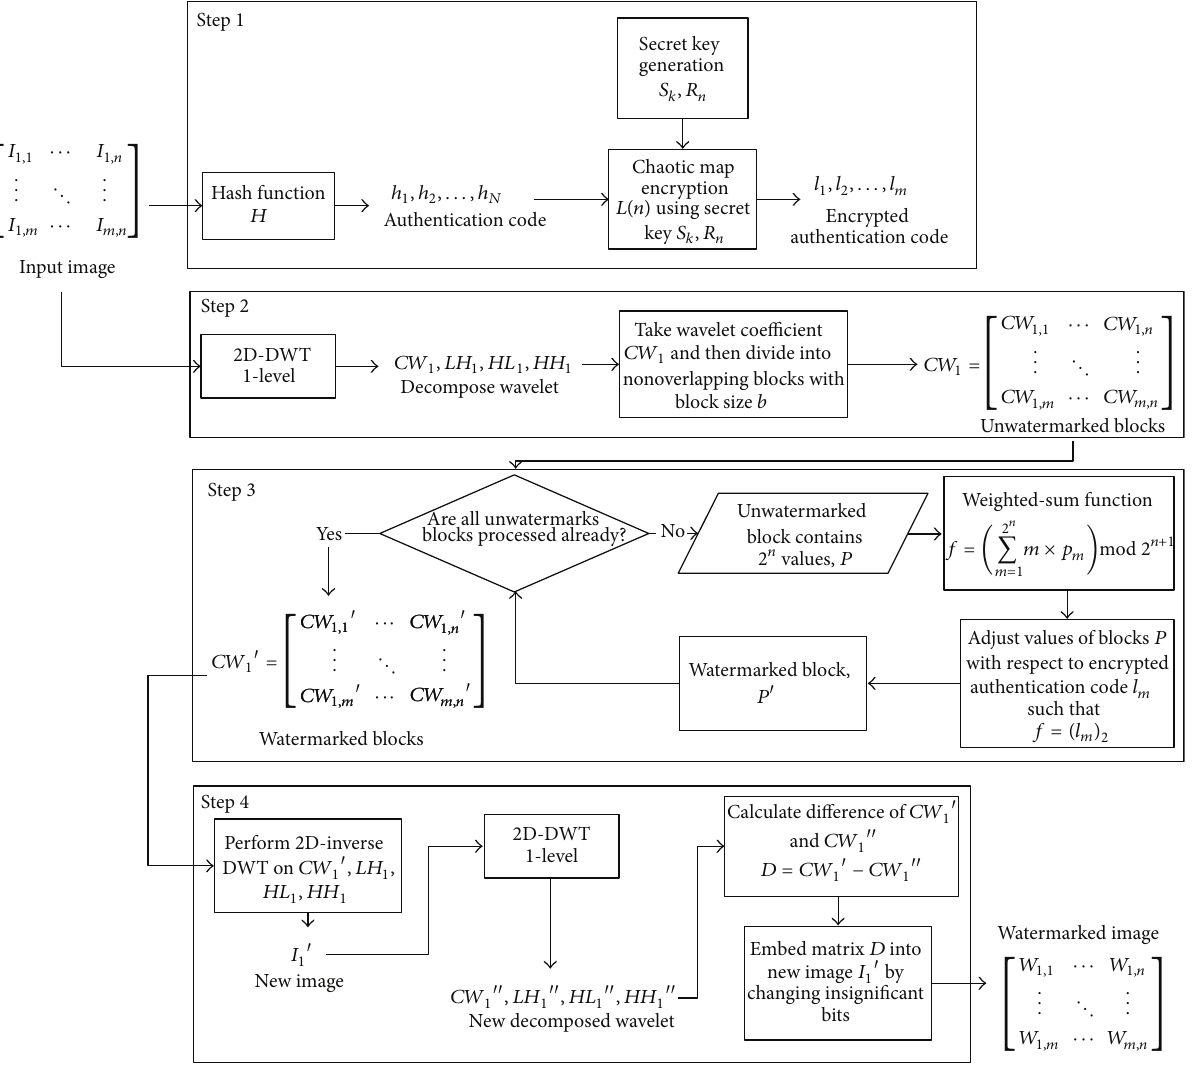
Figure 1: Diagram of the proposed embedding